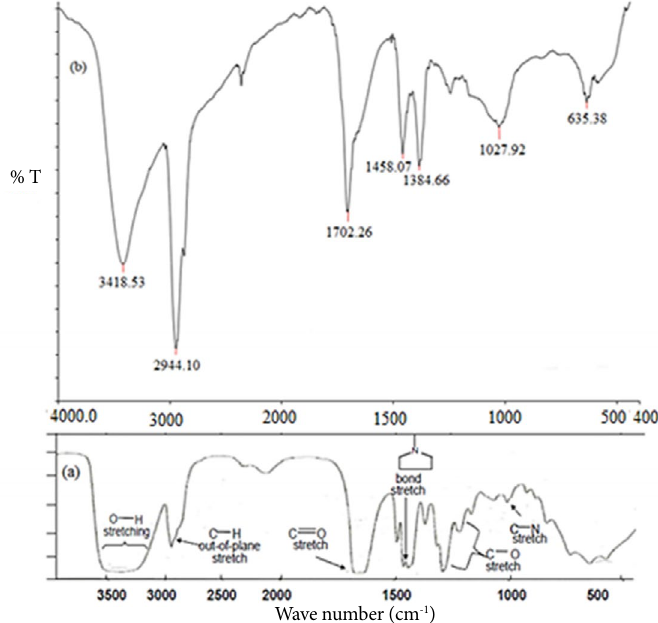
Cu.Wave number (cm Fig. 4. FTIR spectrum for (a) Pure PVP [20] (b) PVP- 50% Cu Fig. 4. FTIR spectrum for (a) Pure PVP [20] and (b) PVP-50%